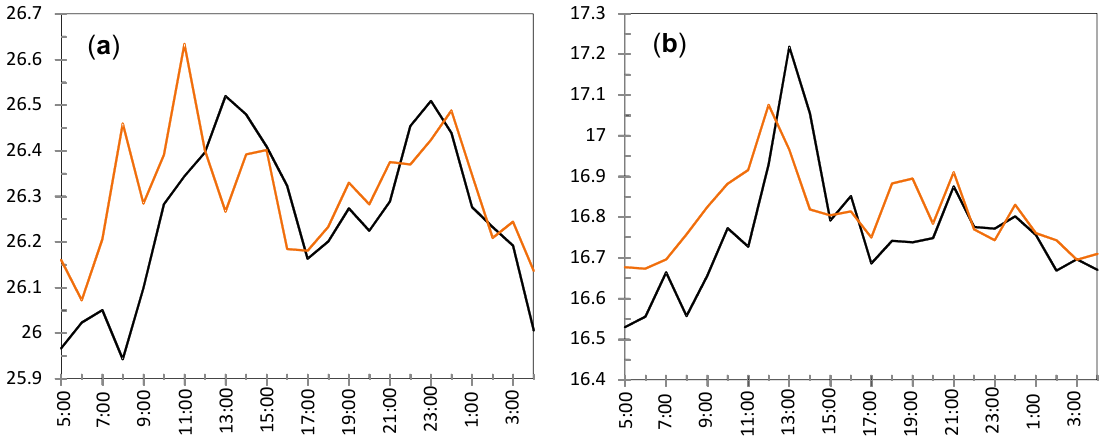
Figure 14. Daily evolution of temperature ( ° C) for nodes RE5 (brown trajectories) and RE6 (black): ( a ) averaged for days 1 to 104, ( b ) averaged for days 105 to 212.